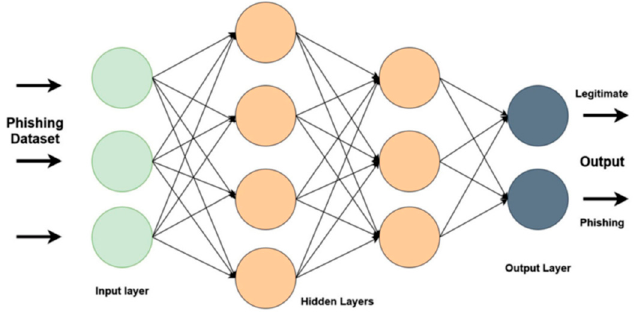
Figure 6 . A deep neural network used for phishing detection [35]. Figure 6. A deep neural network used for phishing detection